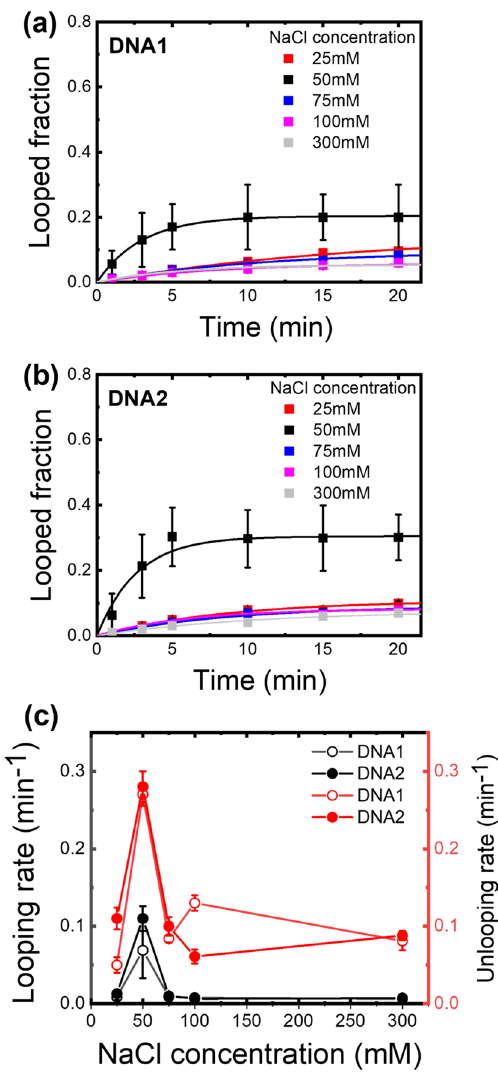
Figure 4. Salt concentration dependent of DNA looping fraction induced by ASRT. ( a ) DNA1. ( b ) DNA2. ( c ) looping (black color) and unlooping (red color) rates of DNA1 (open circles) and DNA2 (filled circles) according to NaCl concentration. In the experiment, the concentration of NaCl was changed to 25 ~ 300 mM. The concentration of MgCl 2 was fixed to 10 mM. The right panel shows the unlooping rate. Error bars are standard errors from three independent